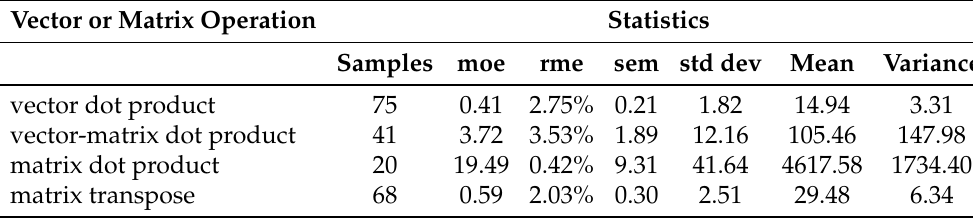
Table 15. Raspberry Pi III B+ benchmark statistics for vector and matrix operations with k = 64 (times in ms).